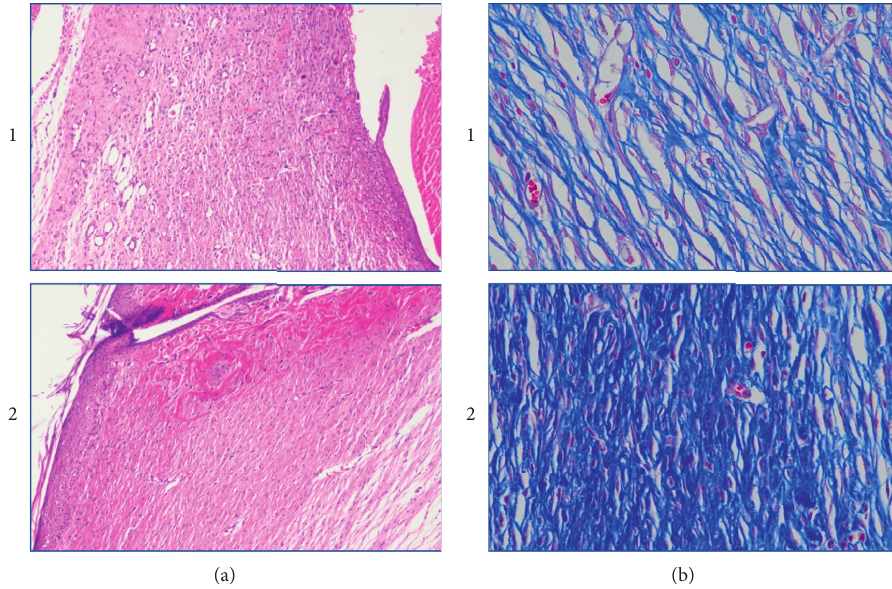
Figure 7: Differential effects of composites on histologic features of wounds at 12 days. (a) H&E staining; (b) MTstaining; CS (1); CS/AuNPs (2).